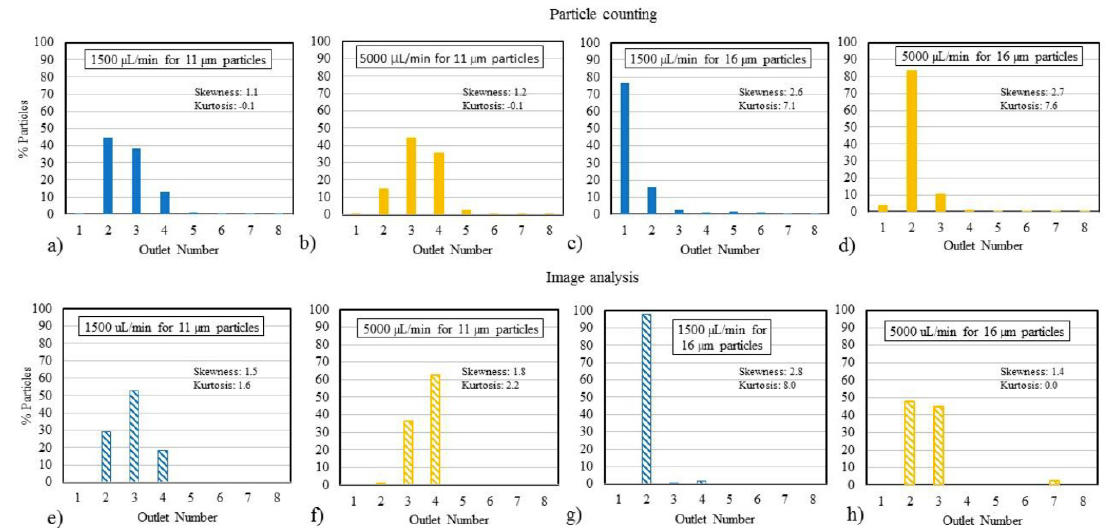
Figure 6. ( a , b ) Particle distributions using the particle counting method for 11- µ m particles at flow rates of 1500 and 5000 µ L / min, respectively. ( c , d ) Particle distribution profiles using the particle counting method for 16- µ m particles at 1500 and 5000 µ L / min, respectively. The high kurtosis value indicates focusing of particles across a narrow range. ( e , f ) Particle distributions using image analysis for 11- µ m particles at flow rates of 1500 and 5000 µ L / min, respectively. ( g , h ) Particle distribution profiles using image analysis for 16- µ m particles at 1500 and 5000 µ L / min, respectively.